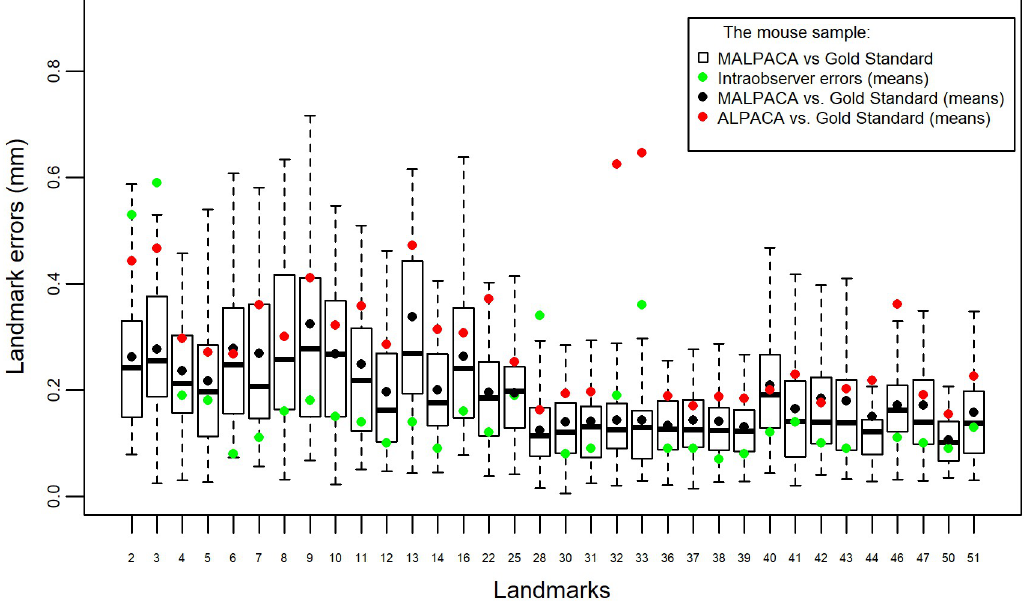
Fig 7. Individual landmark errors of the mouse sample comparing to intraobserver errors. Similar to Fig 2, columns represent errors between MALPACA and the GS for each landmark. Black dots: mean errors of the mouse MALPACA. Green dots: mean intraobserver errors computed by Percival et al. [9]. The labels on the x-axis are landmarks in this study that overlap with those from Percival et al. [9].